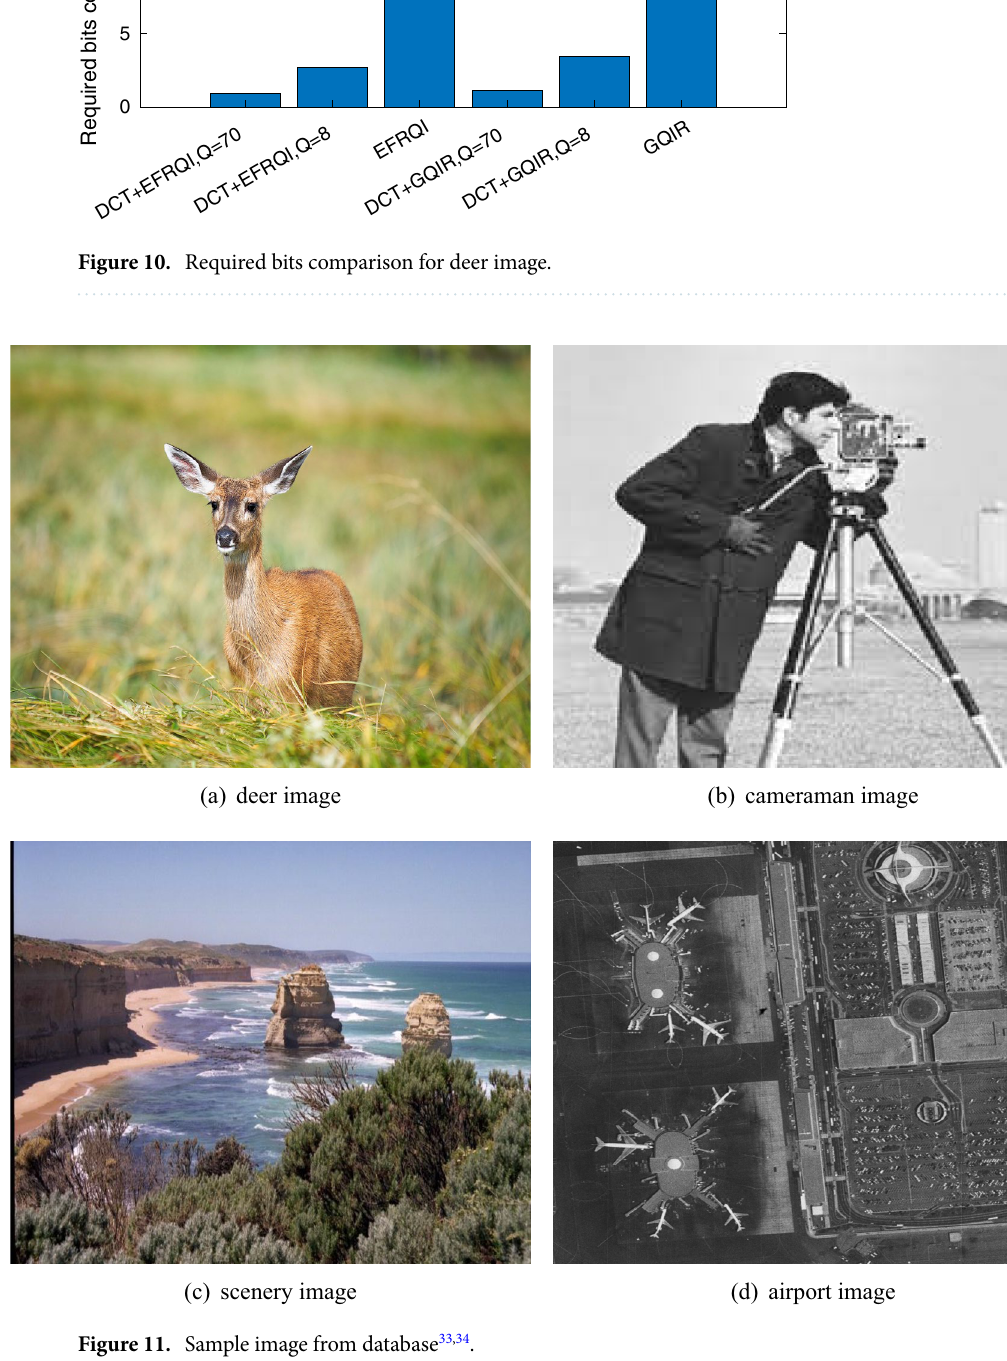
Figure 11. Sample image from database 33,34